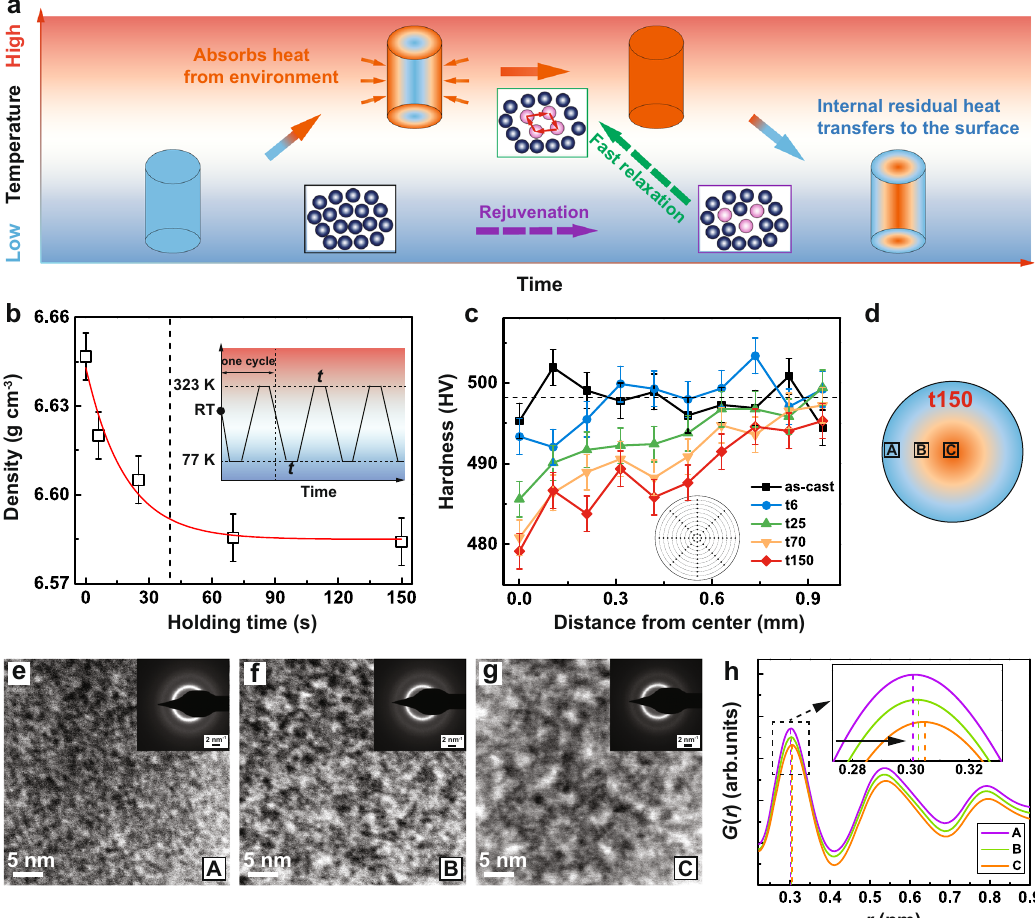
Fig. 2 Generation and Characterization of the GMG with hard shell and soft core. a Schematic of the GMG by means of CTC. b Density values as a function of holding time for the treated MGs. The error bars were obtained by standard deviation from fi fteen independent density measurements. The inset shows the cryogenic thermal cycling procedure from a high temperature (323 K) to liquid nitrogen temperature (77 K), together with the waiting time, t , at both the maximum and the minimum temperatures. c Variation of average hardness value along the distance from the center. The error bars were obtained by standard deviation from 15 independent measurements of hardness.The inset shows the method for hardness measurements along various circles. d Schematic of the t150 sample for TEM. The soft middle and hard edge of the sample were represented by yellow and blue. e – g TEM images with the corresponding selected-area-diffraction patterns (SAED) of the edge, middle, and center regions (labeled A, B, C) for the t150 sample. h Corresponding radial distribution functions, G ( r ), as a function of the distance, r , calculated from the SAED of the edge, middle, and center regions (labeled A, B, C) in the t150